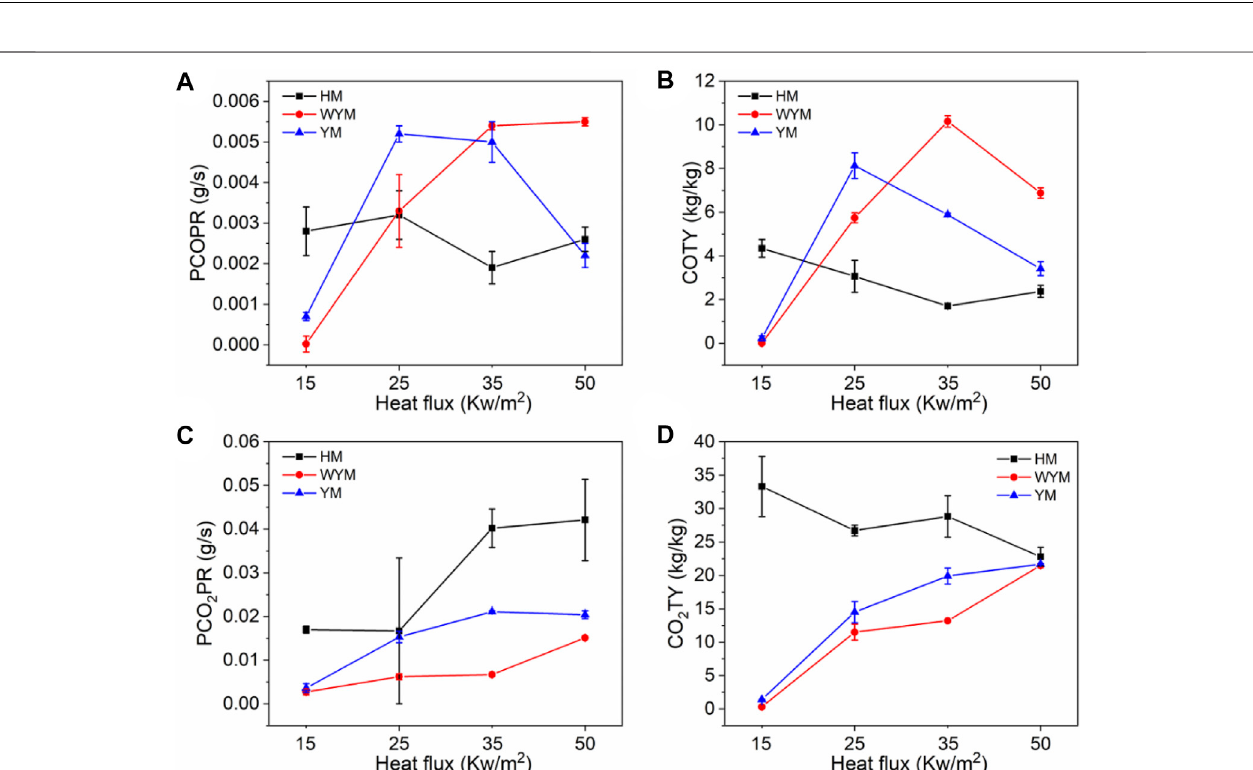
FIGURE 18 | Variation trend of CO and CO 2 : (A) PCOPR, (B) COTY, (C) PCO 2 PR, and (D) CO 2 TY.